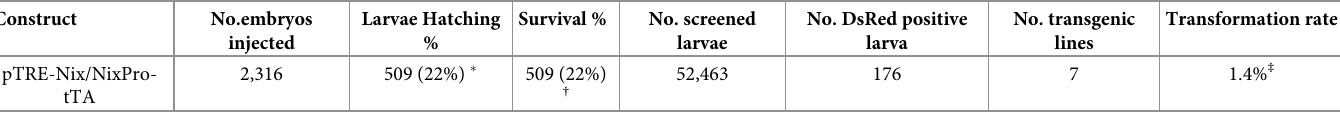
Table 1. Microinjection results of Nix